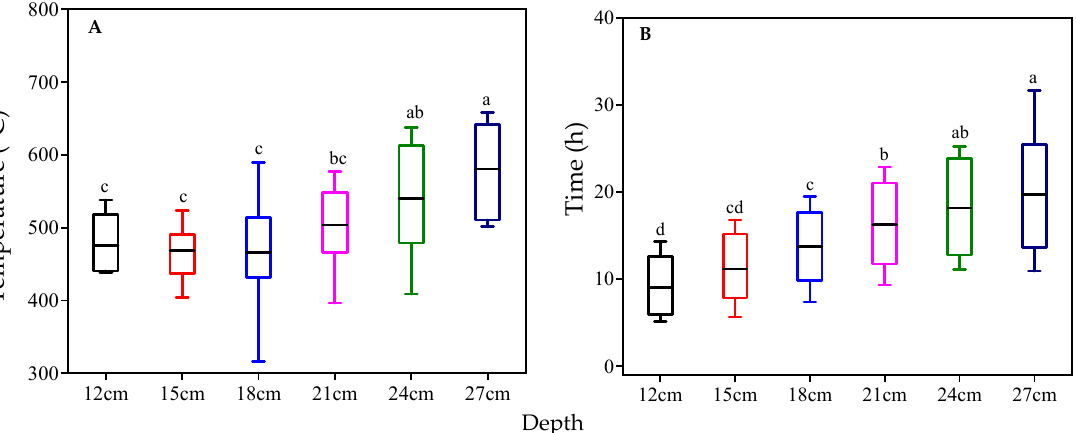
Figure 7. Variance analysis on influence of depth on temperature and combustion period of smol- dering during sub-surface fires ( A : Effect of depth on peak temperature; B : Effect of depth on time; a–d means that if there is any same lowercase letter, the difference is not significant).